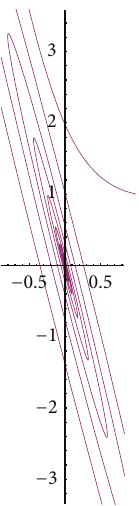
Figure 3: When 𝜏 0 = 0.935 , the periodic solutions occur from the equilibrium (0,0)